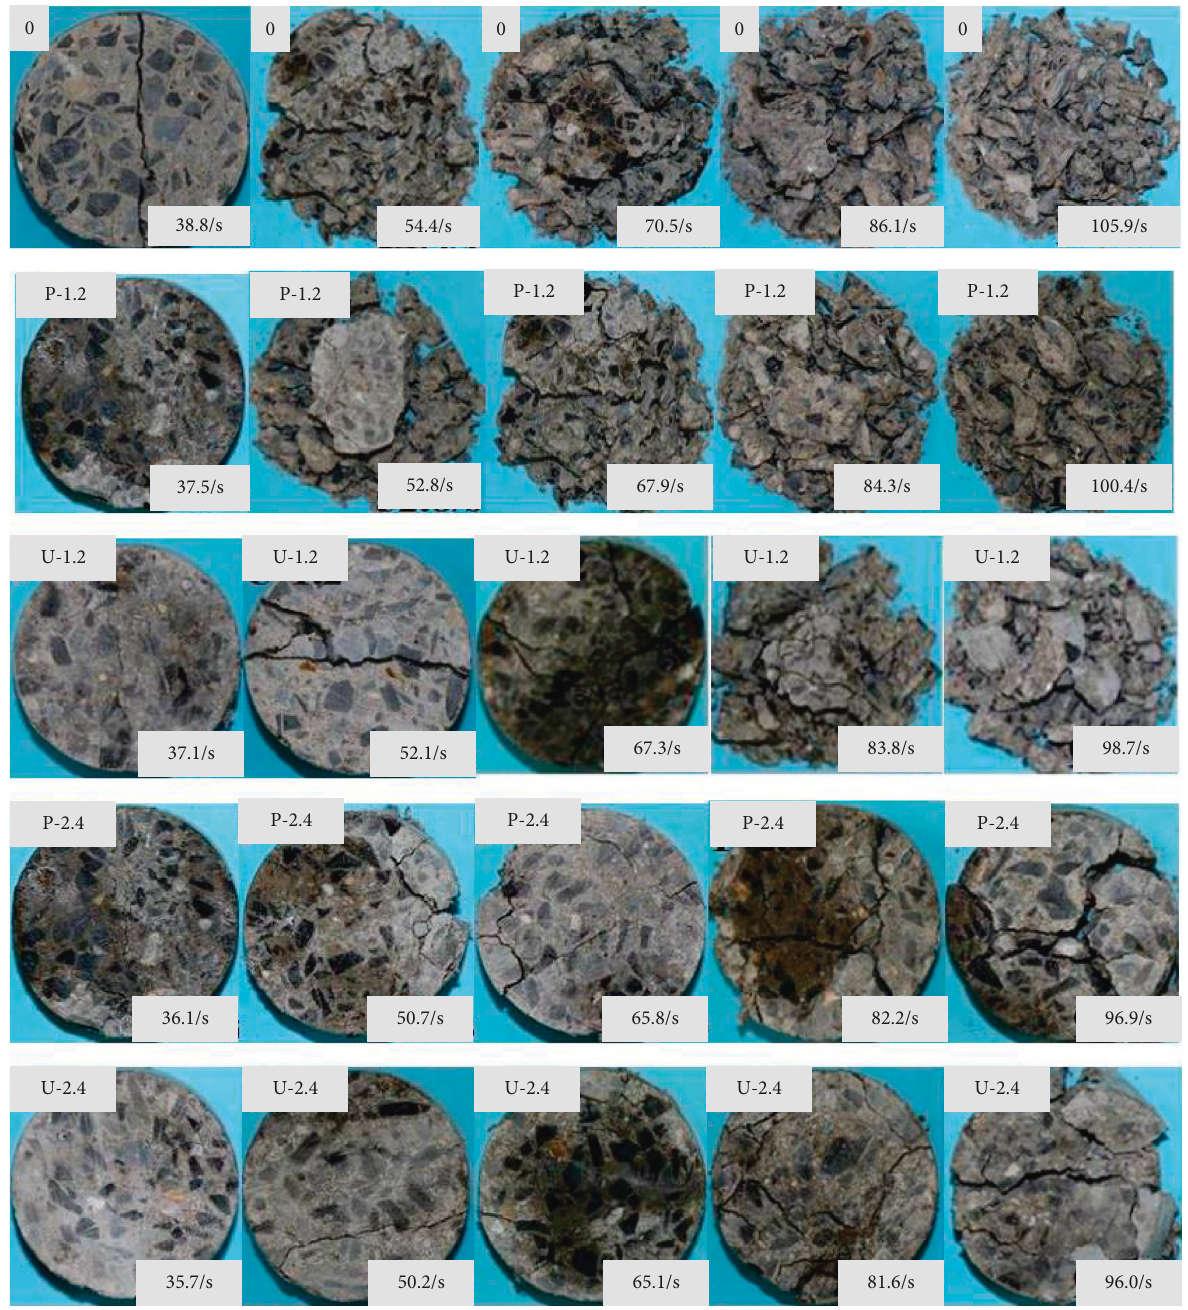
Figure 10: Failure modes of concrete specimens of different groups at different strain rates.